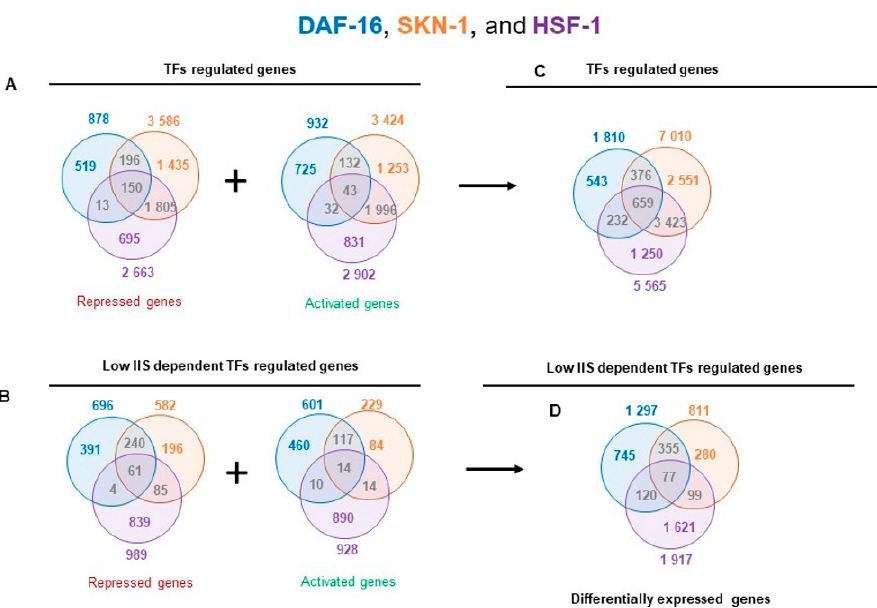
Figure A5. Gene expression profiles of rIIS associated TFs. ( A ) Venn diagram of TF-dependent repressed and activated genes. ( B ) Venn diagram of TF-dependent repressed and activated genes under reduced IIS condition. ( C ) A total of 9034 differentially expressed non-redundant genes regulated by all three TFs. ( D ) A total of 3297 non-redundant differentially expressed genes regulated by all three TFs under rIIS conditions.